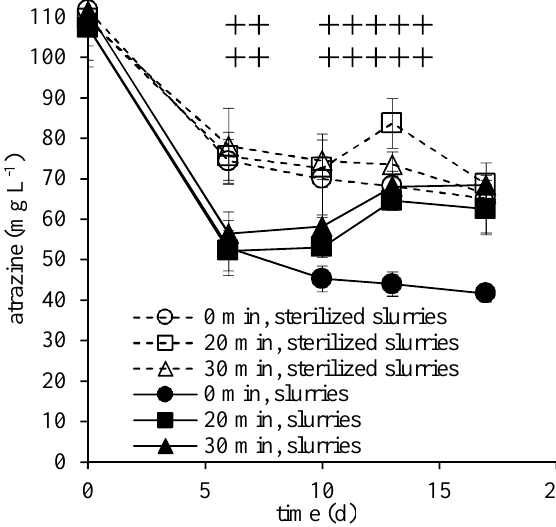
Figure 2. Atrazine concentrations ( n = 3) in the slurries and sterilized slurries, all sonicated for 0, 20, or 30 min. Two sonications per day are marked with